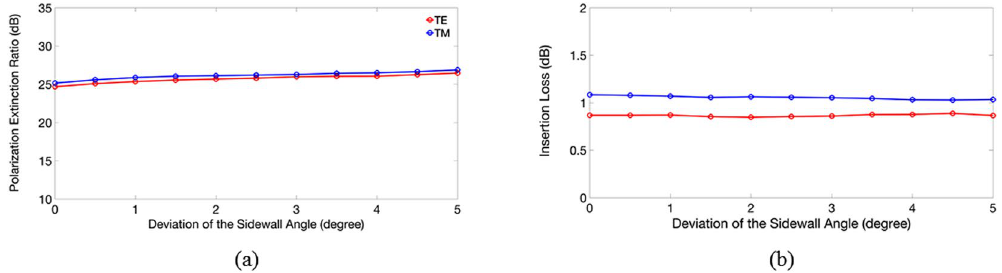
Figure 9. The calculated ( a ) PERs and ( b ) ILs of the TE and TM modes versus the deviation of the sidewall